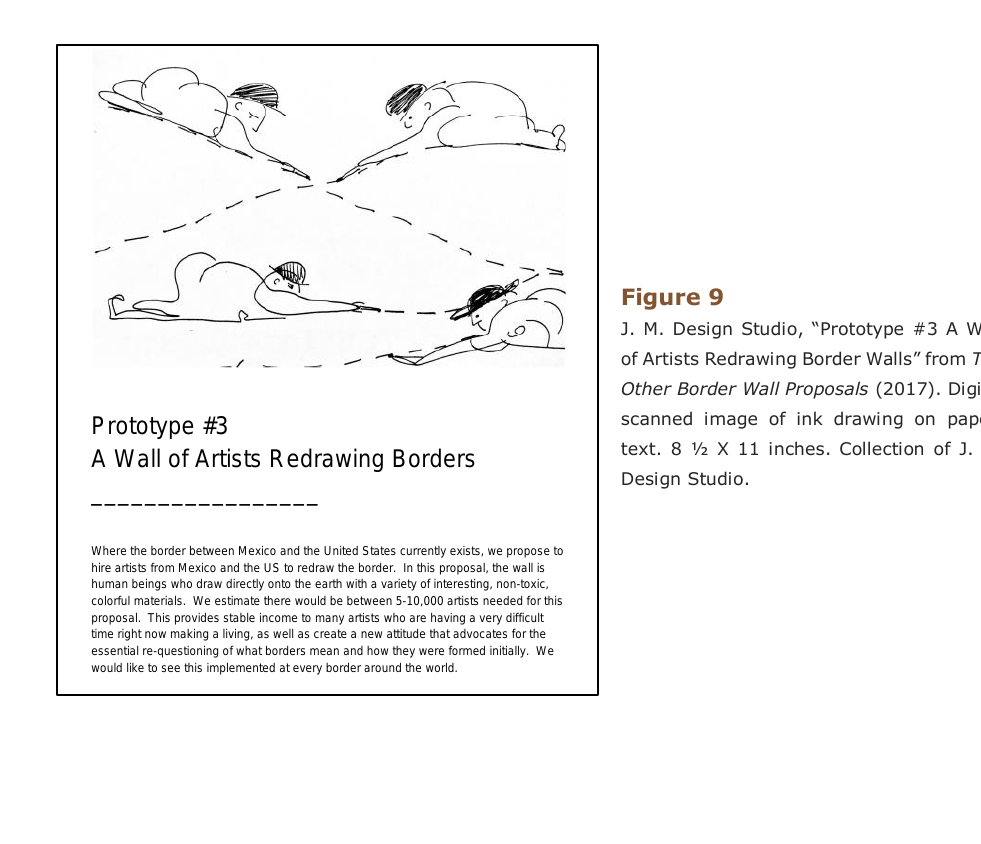
J. M. Design Studio, “Prototype #6 A Wall of Clean Water” from The Other Border Wall Proposals (2017). Digital scanned image of ink drawing on paper, text. 8 ½ X 11 inches. Collection of J. M. Design Studio.